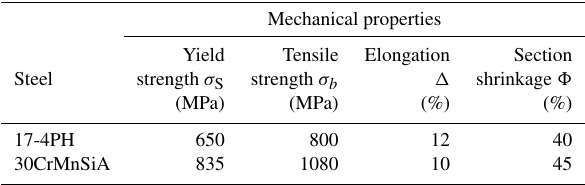
Table 3. Material parameters of the confined